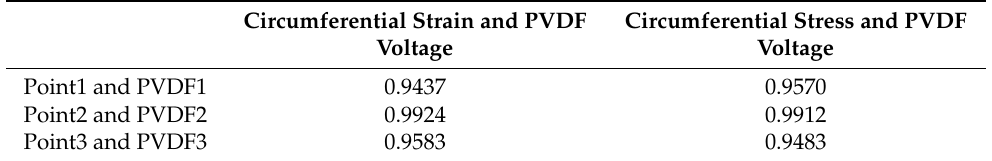
Table 3. Correlation coefficient.